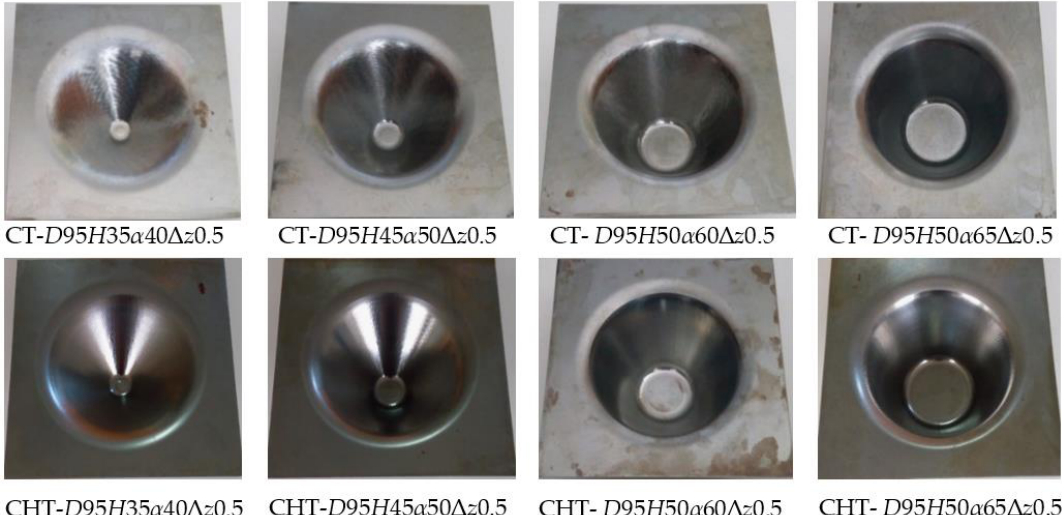
Figure 10. Parts machined with conventional forming tool (CT) and CHT forming tools, reprinted with permission from ref. [5].